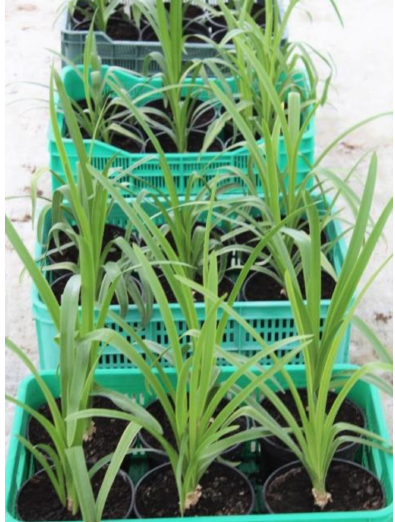
Figure 2. × A. tubergenii “Zwanenburg” plants on the 70th day after